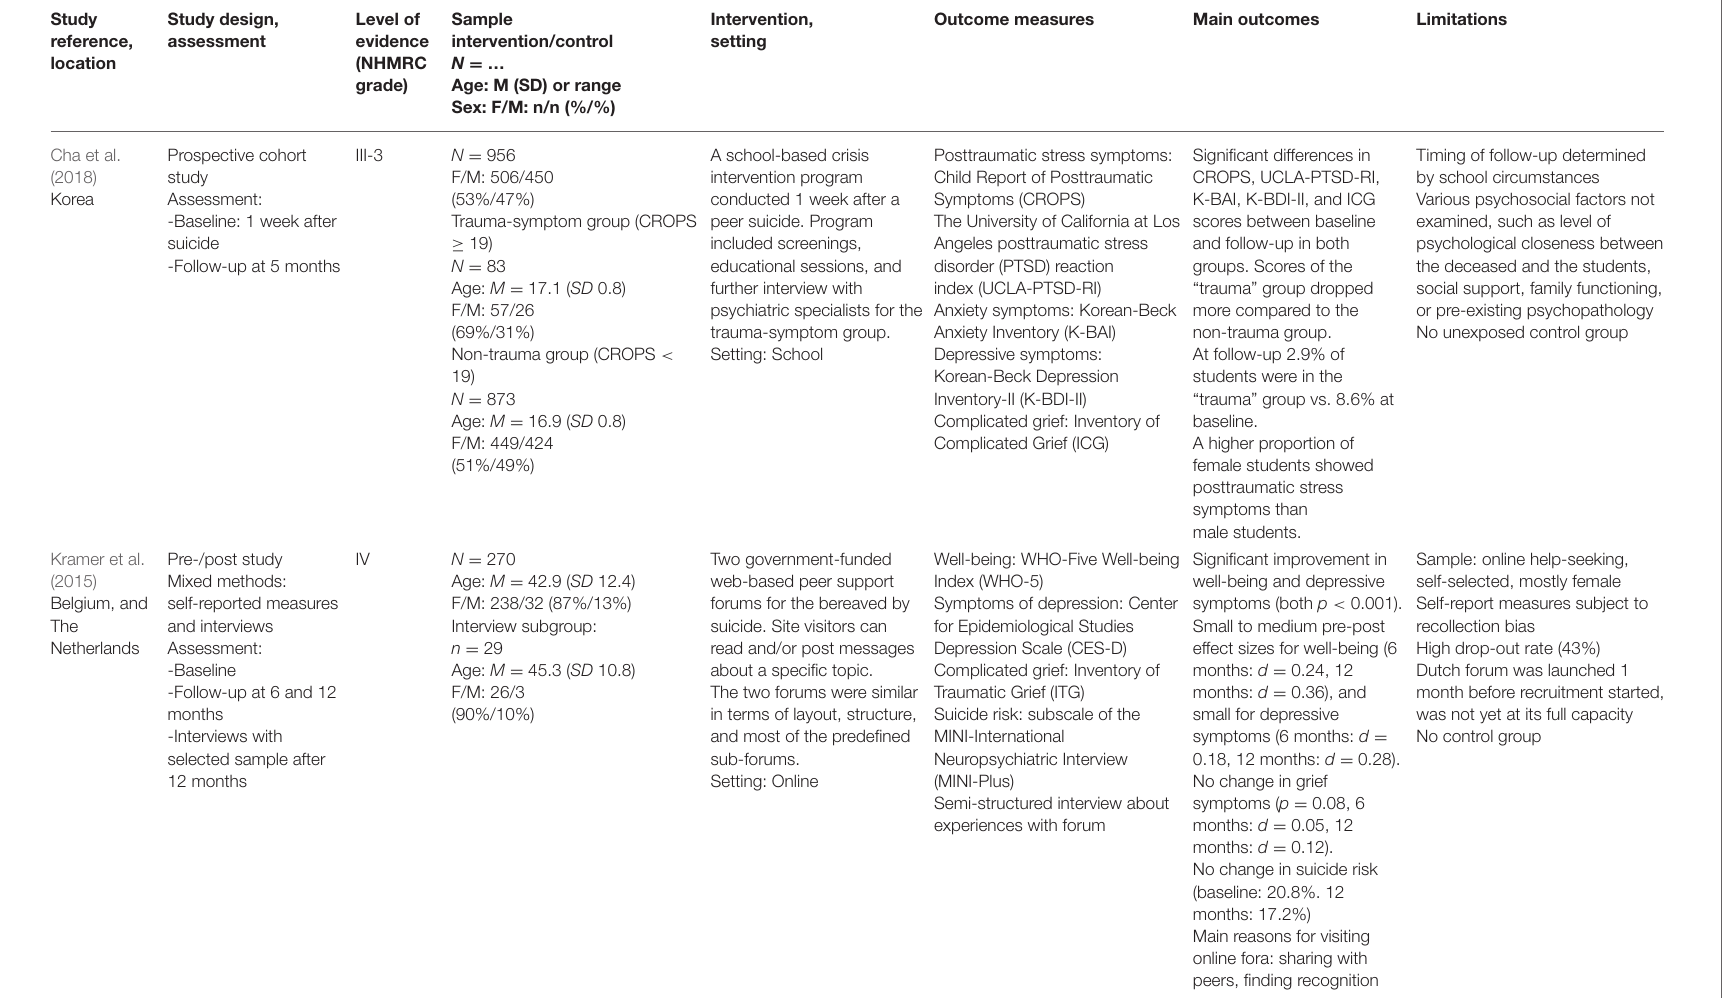
TABLE 1 | Summary of included studies. Study reference,